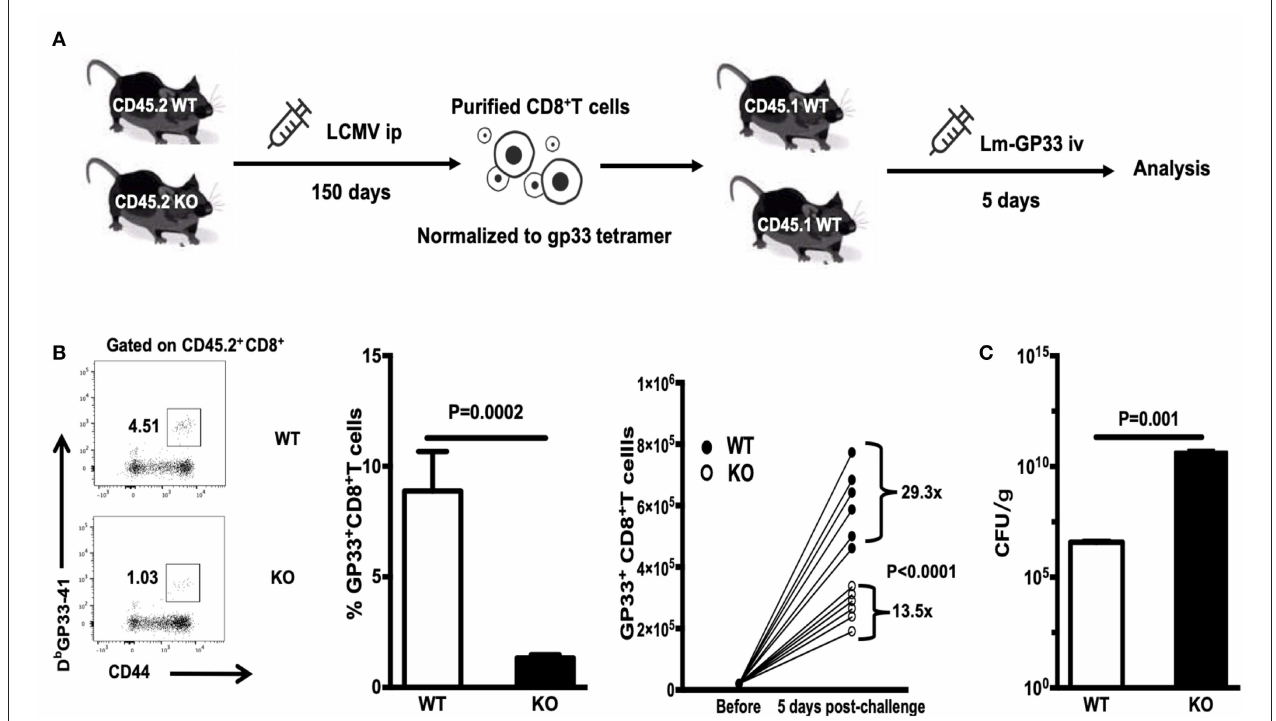
FIGURE 8 | WASp − / − mice mount impaired secondary CD8 + T cell responses. WT and WASp − / − mice were sacrificed on D150 PI. Equal numbers of GP33 + CD8 + T cells were adoptively transferred to naïve congenic recipients, which were challenged on the next day with Lm-GP33. At 5 days post-challenge, the -fold increase in the number of transferred GP33-specific CD8 + T cells was determined. (A) Experimental design. (B) Representative data of the percentage of GP33 specific CD8 + T cells (left panel), Histogram show the percentage and -fold expansion of GP33-specific cells in WT and WASp − / − mice (middle and right panel). (C) The Lm load was calculated by serial dilution on BHI agar. Data are expressed as the mean ± SEM ( n = 6 mice per group) and were analyzed using an unpaired t